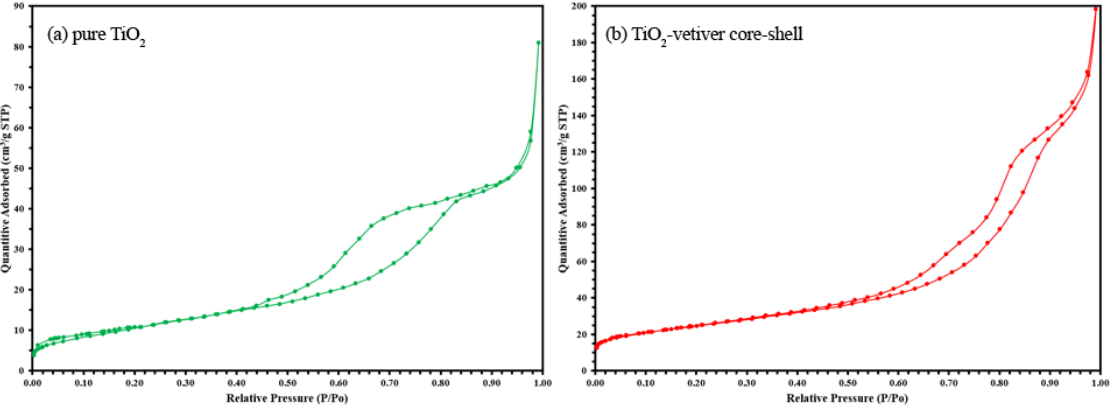
Nitrogen adsorption–desorption isotherm plots for ( a ) pure TiO 2 ; and ( b ) TiO 2 ‐ vetiver core–shell.